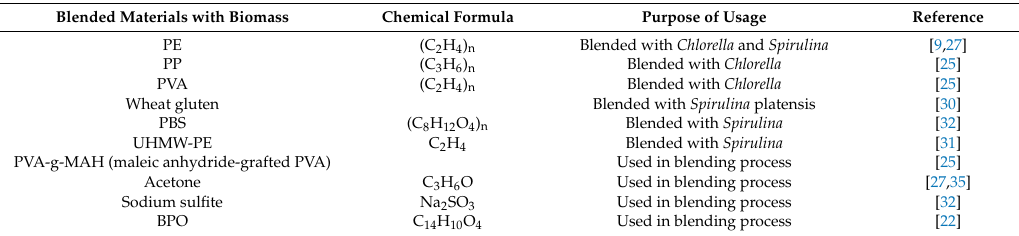
Table 5. Blended materials with microalgae and used chemicals in the blending process. Blended Materials with